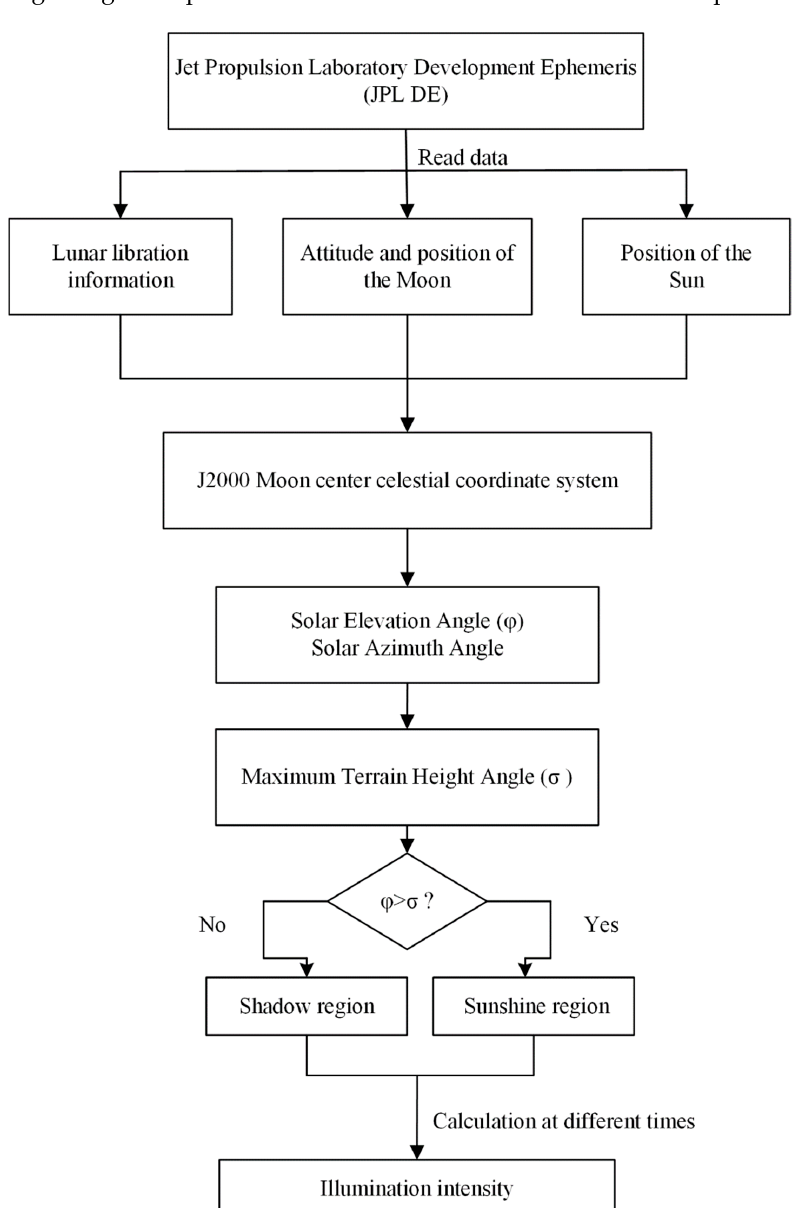
Figure 3. The calculation methods used to obtain illumination